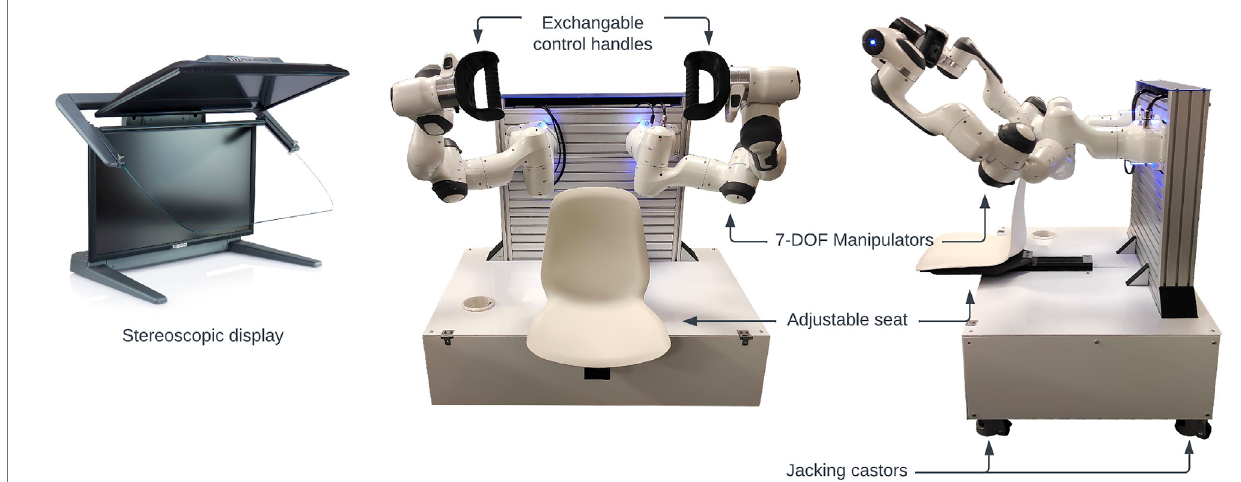
FIGURE 2 | Overview of the hardware components of the PARTI system.